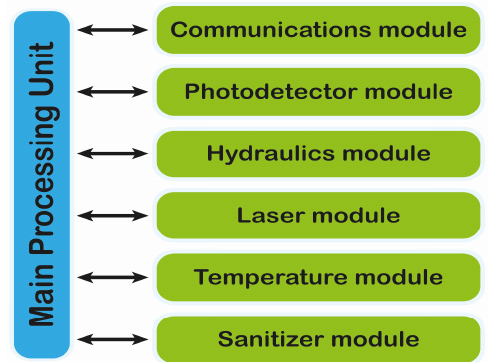
Figure 5. Main processing unit involved in the control and communication of the device.